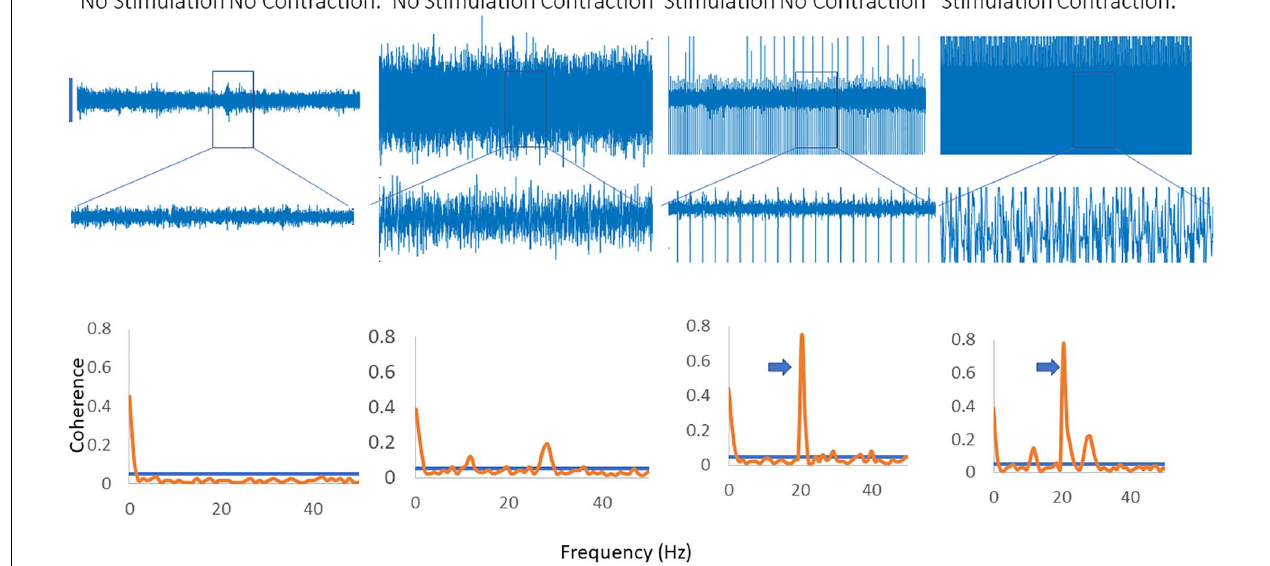
FIGURE 4 | Inter-muscular coherence from the upper limb is shown with a background contraction and no stimulation, a contraction and 20 Hz stimulation and a contraction with stimulation at the peak frequency in the coherence spectra. In the 20 Hz stimulation contraction there is a peak in the coherence at 20 Hz along with the original peak in the coherence spectra. The trace shows the effects of stimulating at the peak frequency of the background coherence spectra. A new peak emerges at a lower frequency in the spectra. In the coherence plots the arrows indicate the peak in the coherence as a result of the